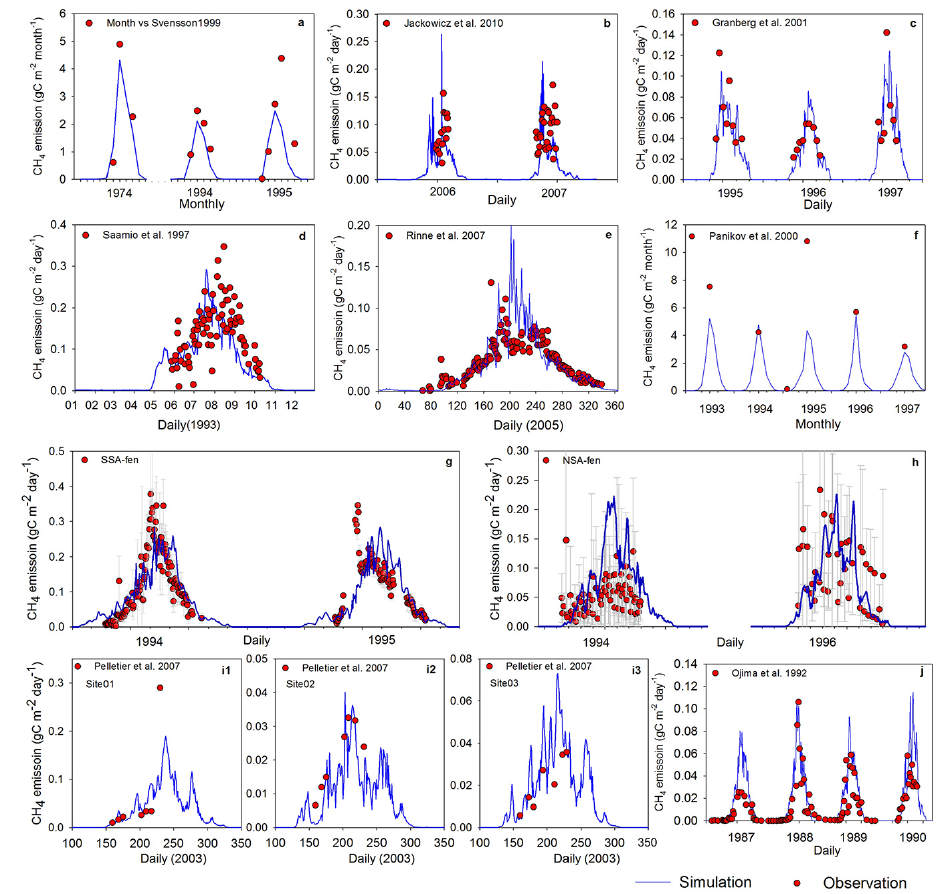
Figure 3. Comparison of modelled and observed CH 4 emissions for the sites located in the boreal